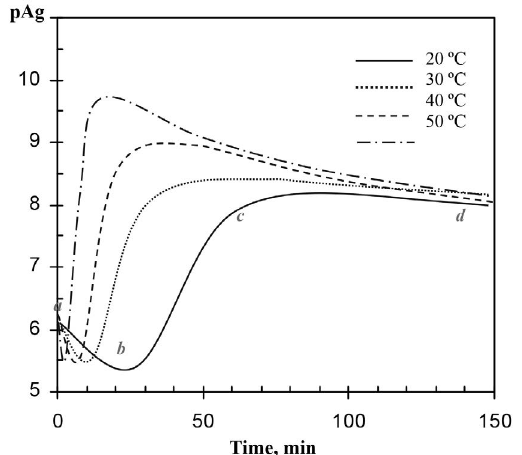
Fig. 4. The рAg potentiometric curves as a function of time for sil- ver nanoparticles formation process at different